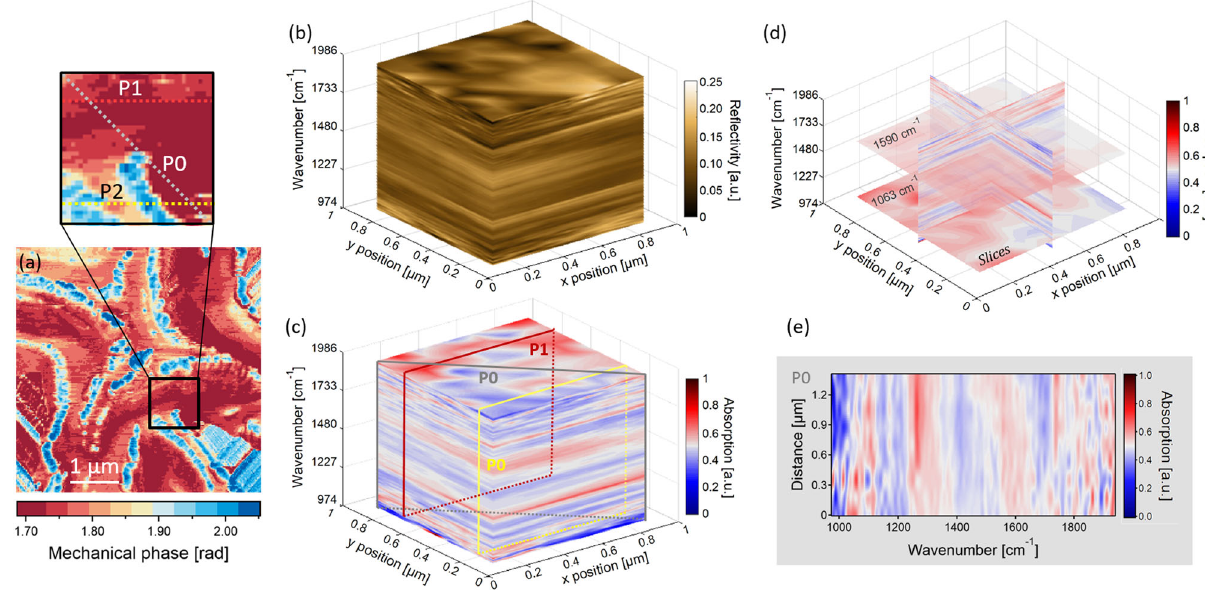
Fig. 3 Hyperspectral imaging of plant material. a Mechanical phase measurement of a 5 × 5 µ m 2 region of an EA sample. Hyperspectral mappings are carried out for the 1 × 1 μ m 2 region demarcated in a . Hyperspectral intensity data-cubes, I ( x , y , v ) contain re fl ectivity ( b ) or absorption ( c ) information. d Slices were extracted from the absorption data cube at 1063 cm − 1 and 1590cm − 1 , corresponding to the speci fi c absorption of cellulose and lignin, respectively. e Spectral mapping of the absorption recorded for wavenumbers in the range 974 – 1986 cm − 1 along plane P0 (gray) (Planes P1 and P2 will be used further, see Fig.